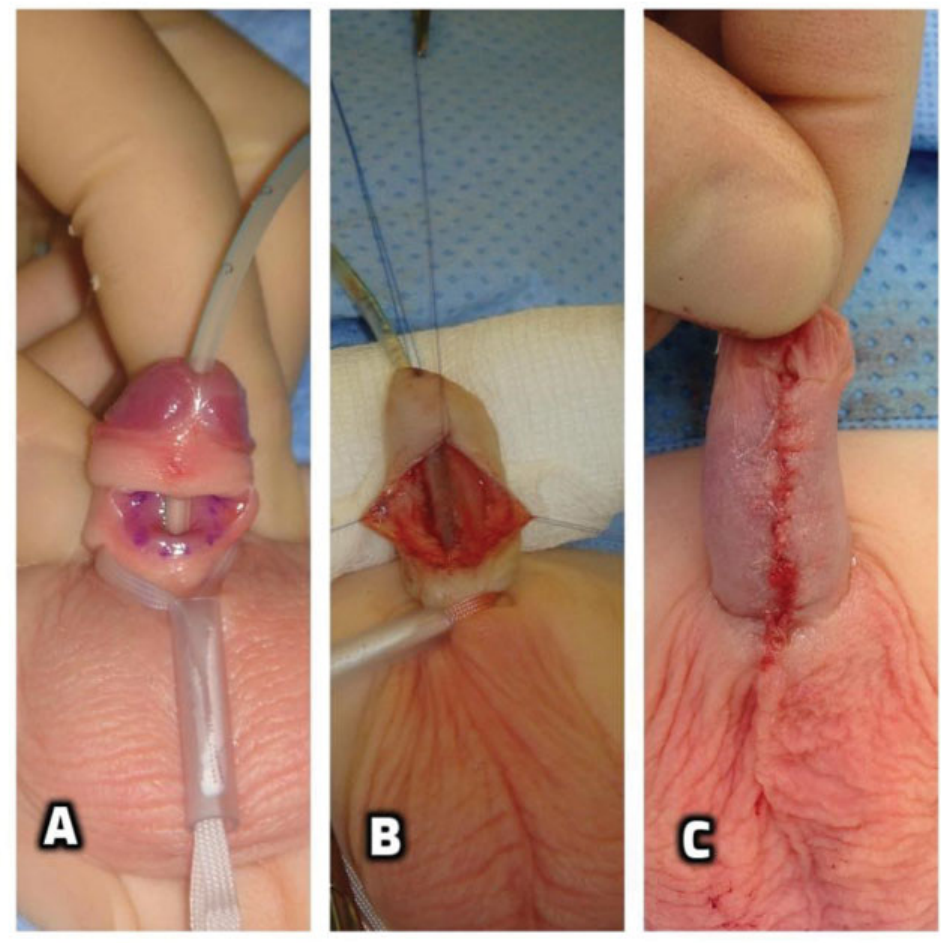
Fig. 2 Intraoperatively, a 6 F catheter was passed through normal caliber distal and proximal urethra ( A ). Thiersch ‒ Duplay continuous urethroplasty ( B ). Skin closure and fi nal intraoperative appearance ( C